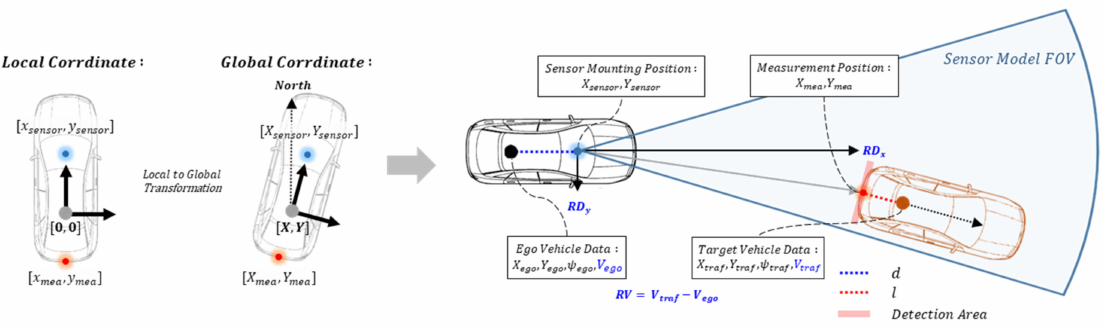
Figure 8. Concept of perception sensor